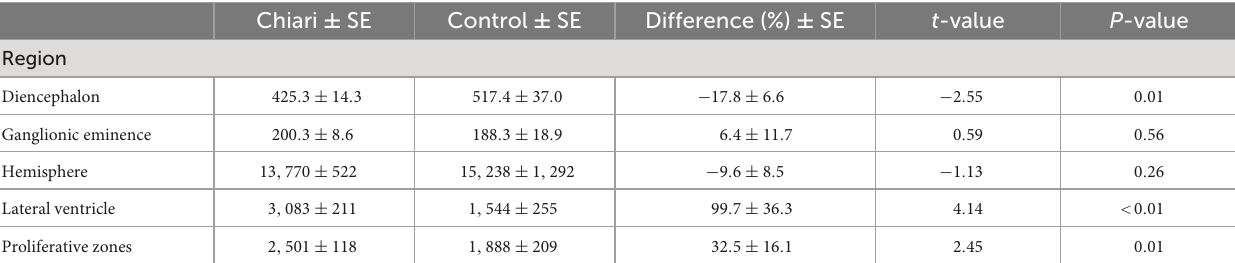
TABLE 2 The volume of segmented clusters in the Chiari II and controls [cc], and comparison between two groups (% difference) with standard errors (SE), t -values, and p -values from the regression